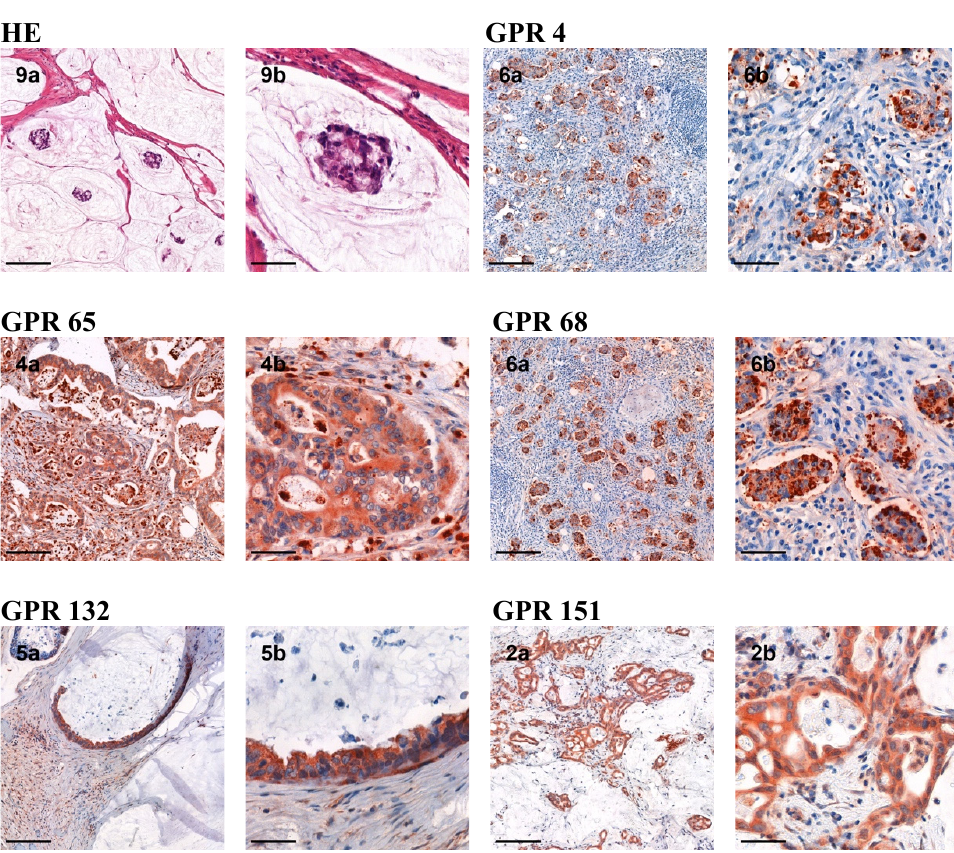
Figure 1. Expression of GPR4, GPR65, GPR68, GPR132, and GPR151 of peritoneal carcinomatosis of colorectal cancer. The number on each slide corresponds to the patient number (compare also Table 1). “(a)” represents a 10-fold magnification (scale bar 200 µ m) and “(b)” a 40-fold magnification (scale bar 50 µ